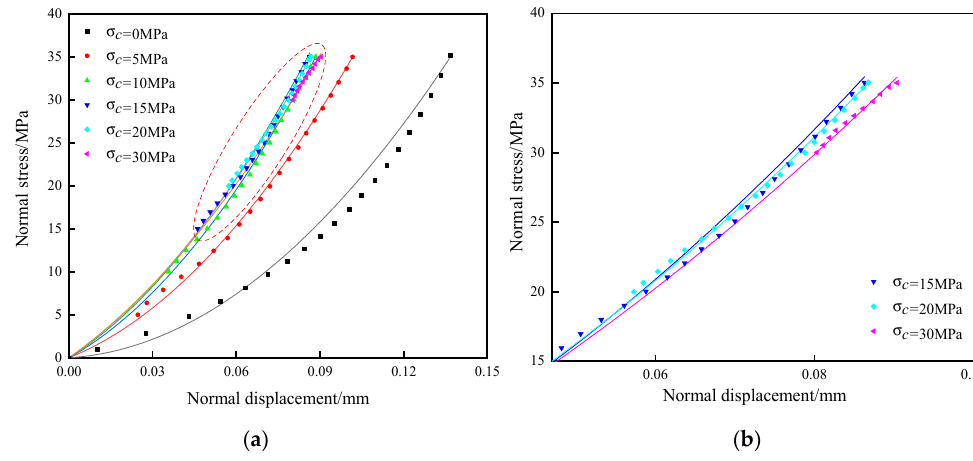
Figure 11. Comparison of the test and fitting results of the relationship of normal stress and normal displacement: ( a ) σ c = 0,5,10,15,20,30 MPa, ( b ) σ c = 15,20,30 Table 5. Fitting parameters of normal compression test.